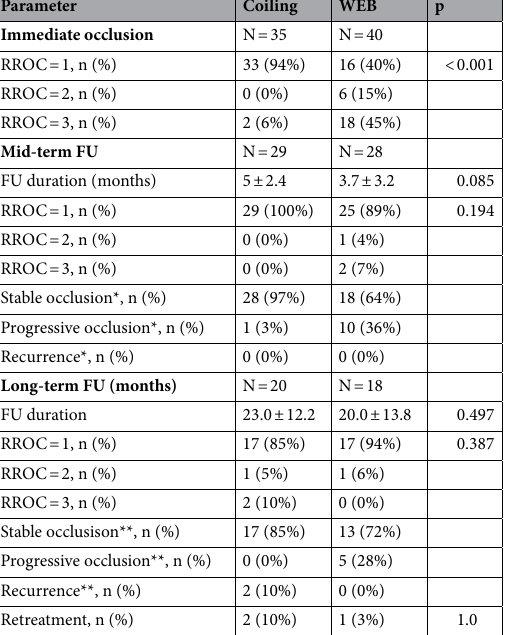
Table 4. Angiographic outcome. RROC Raymond–Roy Occlusion Classification, FU follow-up. *vs. Immediate postinterventional occlusion. **vs. Mid-term